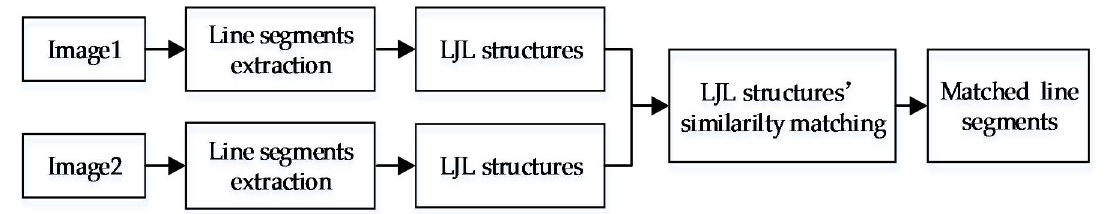
Figure 4. Line matching process using the line-juncture-line (LJL) method.